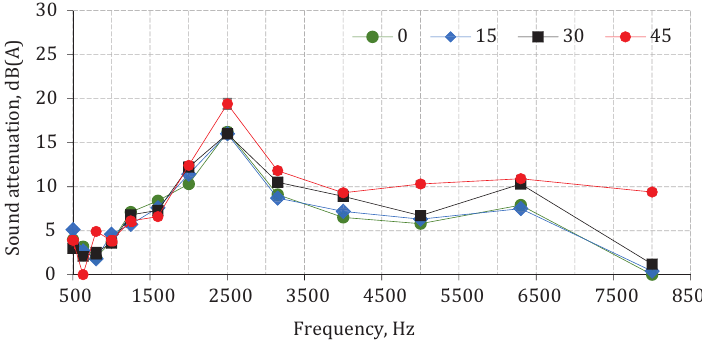
Figure 7. Energy growth per area of the barrier without sound-absorbing material